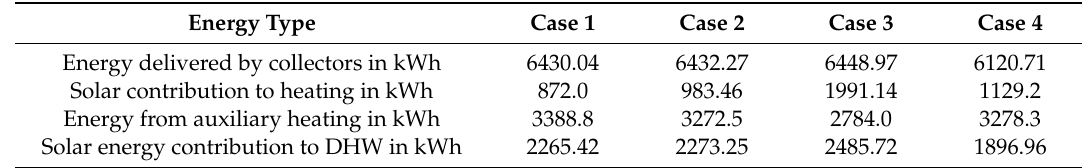
Table 3. Yearly results from energy simulations for all